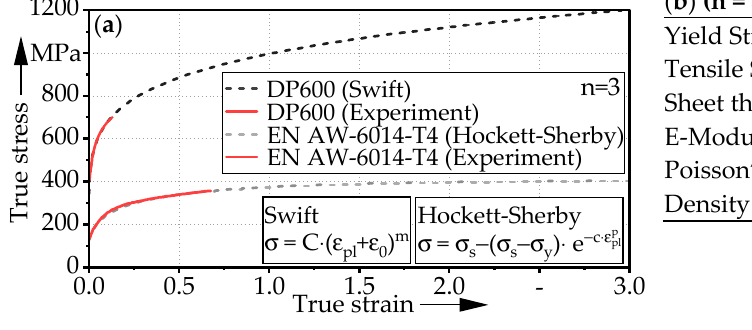
Figure 1. ( a ) Flow curves of the material used for the numerical simulation. The flow curve of DP600 was derived from the uniaxial tensile test in the rolling direction and extrapolated using the Swift [22] strain hardening model. The flow curve of EN AW-6014-T4 was derived from the bulge test and extrapolated using the Hockett–Sherby [24] strain hardening model. ( b ) Mechanical properties of the used materials.